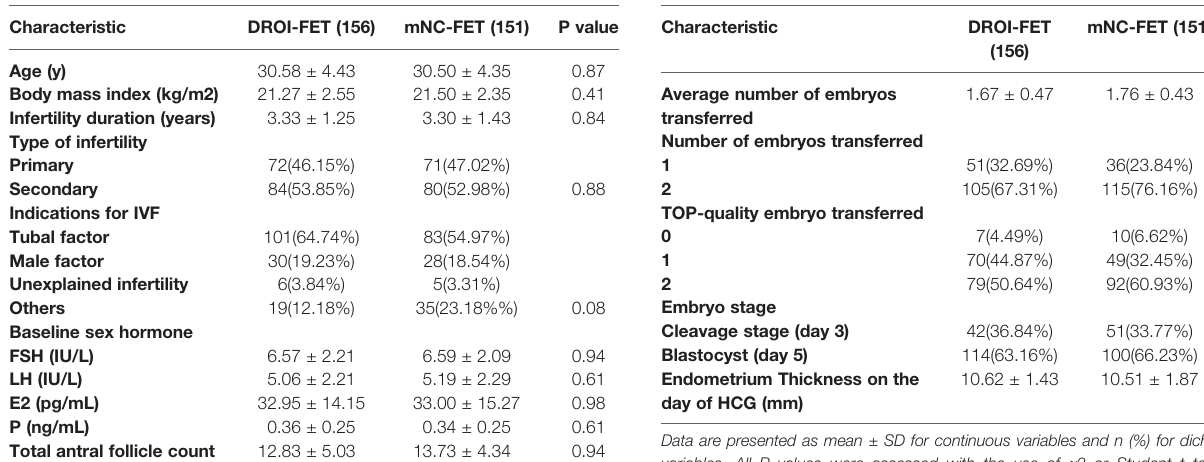
TABLE 1 | Basic characteristics of patients at the cycle level. TABLE 2 | Cycle characteristics at transfer